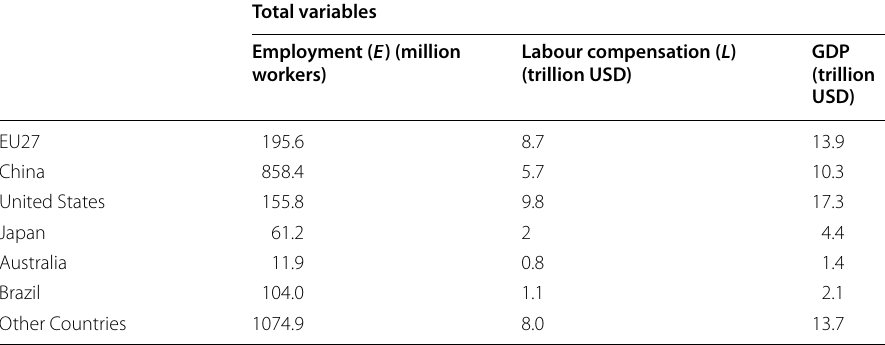
Table 1 Aggregate Employment Data, 2014 Source: Author’s calculations based on the